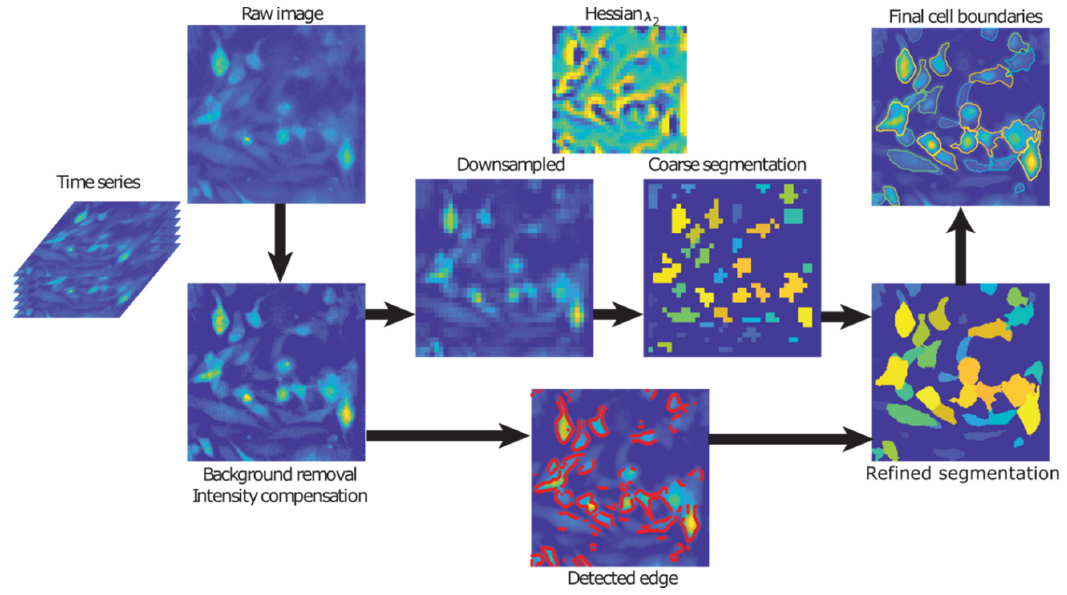
Figure 6. Image processing steps from raw image acquisition to segmentation of final cell boundaries. Cancers 2020 , 12 , x